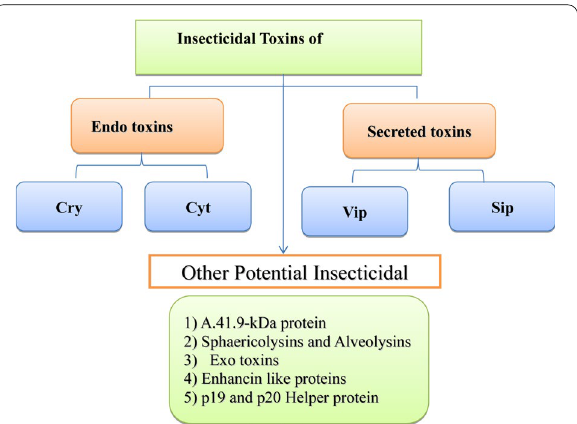
Fig. 2 A summarized illustration of the different Bacillus thuringiensis toxins produced during its vegetative and sporulation phase. The two different δ-endotoxins, Cry (Crystal proteins) and Cyt (Cytotoxic proteins) are produced during sporulation and the other two secreted proteins, Vip (vegetative insecticidal proteins) and Sip (secreted insecticidal proteins) are produced during vegetative phase. The list of five other potential insecticidal toxins like A.41.9-kDa protein, Sphaericolysins and Alveolysins, β Exotoxins, Enhancin like proteins, p19 and p20 Helper protein were also listed in the